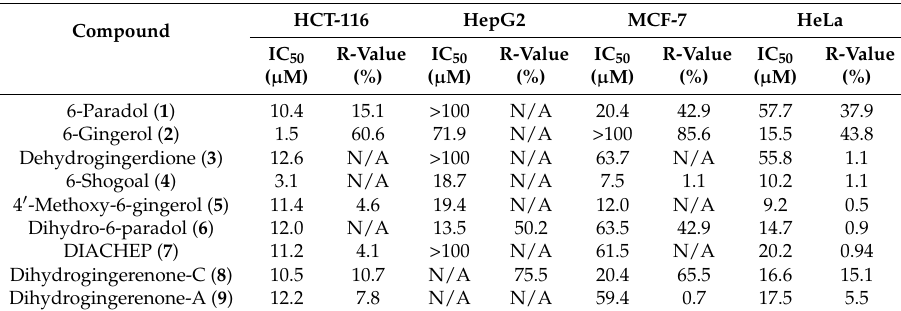
Cytotoxicity parameters of some naturally occurring hydroxyphenylalkanes and diarylheptanoids against different solid tumor cell